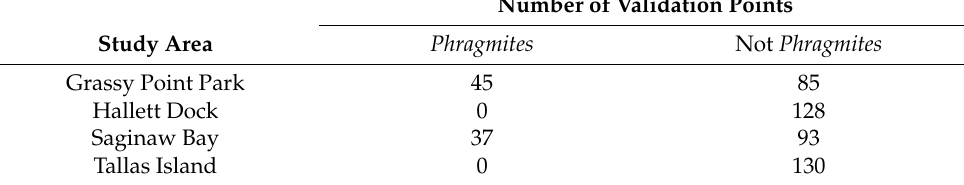
Table 4. Number of validation points randomly generated by class in each study area. No validation points were generated for the Phragmites class in Tallas Island and Hallett Dock due to no populations of Phragmites existing within those study areas. Fifty validation points were originally generated for Phragmites in Grassy Point Park and Saginaw Bay, but were reduced due to points falling within gaps in the Phragmites patches.